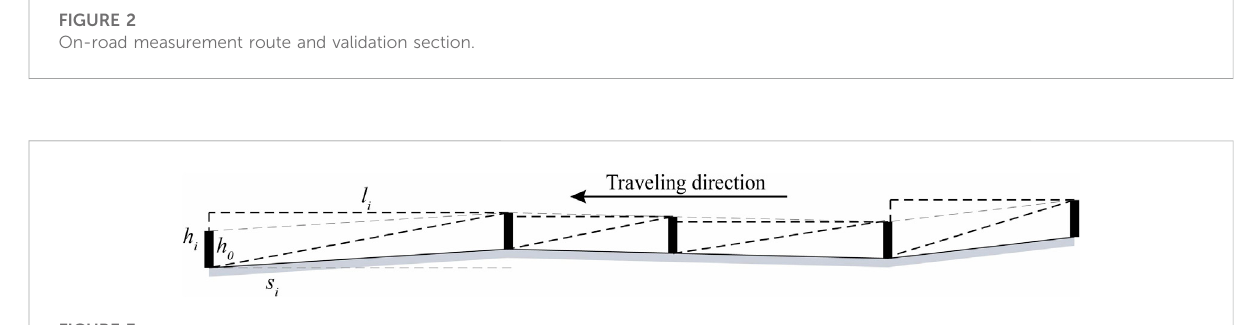
FIGURE 3 Laser range fi nder-based grade measurement